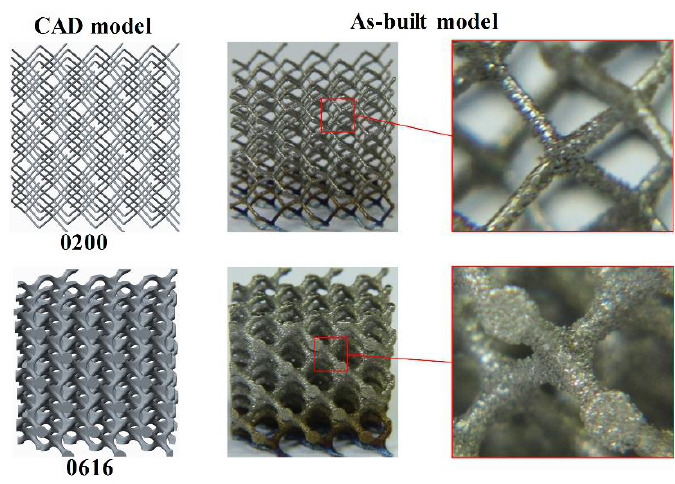
Figure 5. Comparison between CAD models and as-built samples.